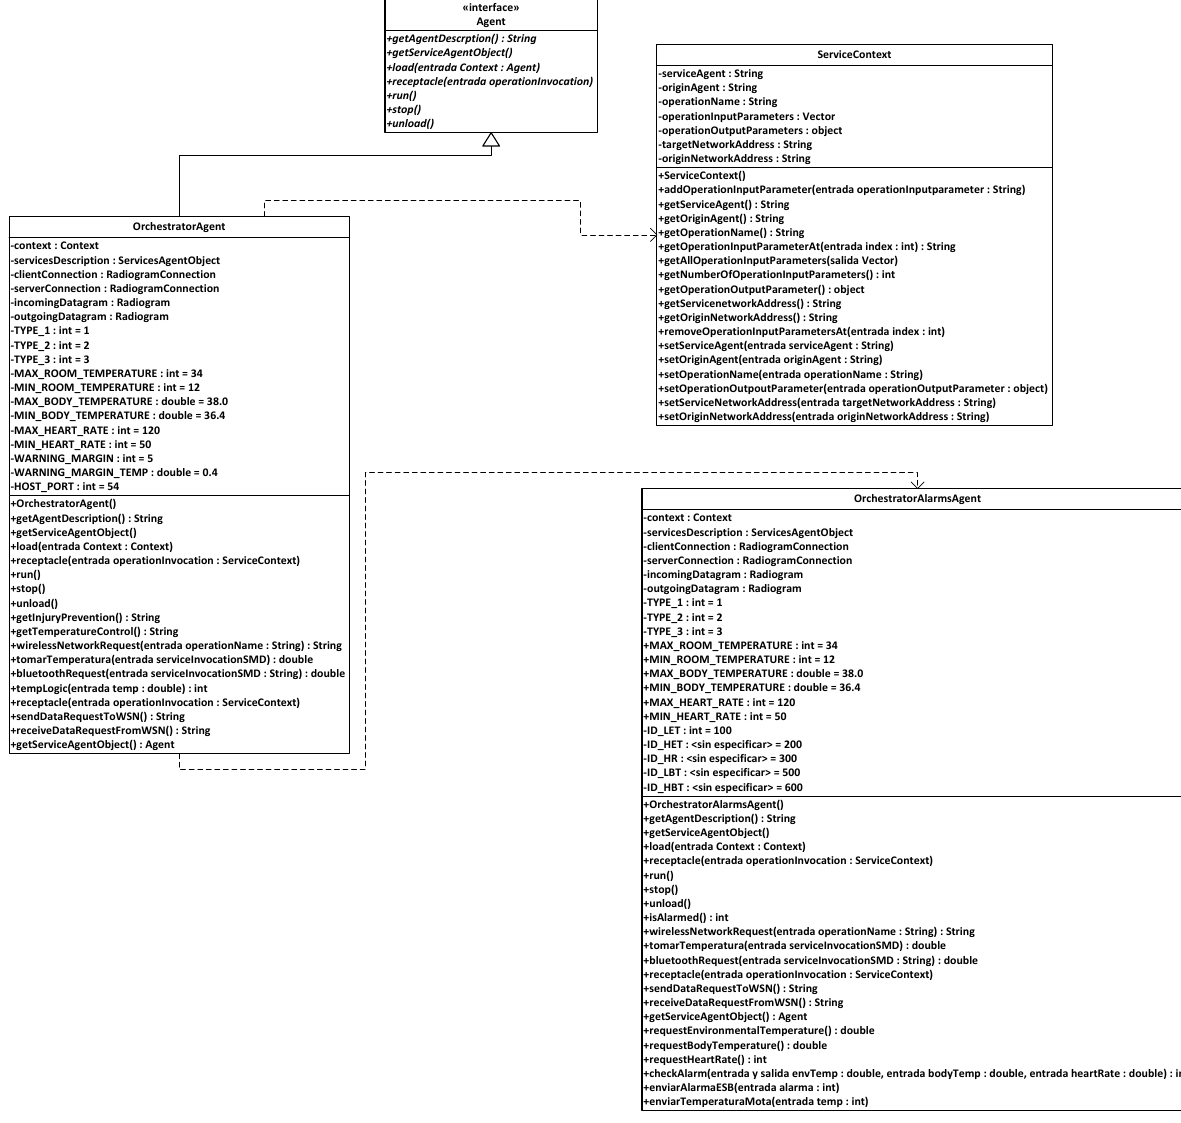
Figure 15. Interrelating class diagram of the Orchestrator and Orchestrator alarms agents.